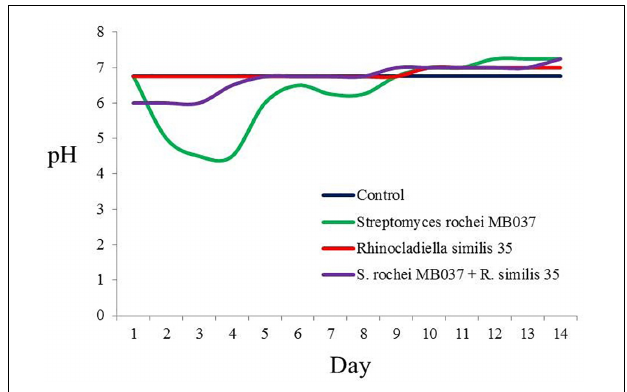
FIGURE 7 | pH trends of pure culture and co-culture of S . rochei MB037 and R . similis 35.